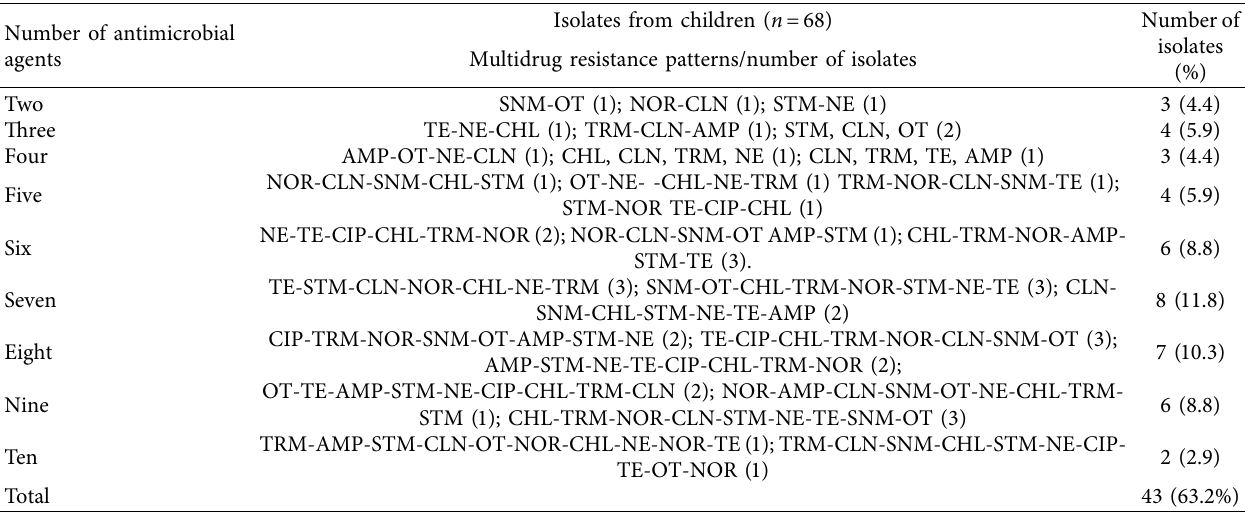
Table 4: Multidrug resistance patterns of Escherichia coli